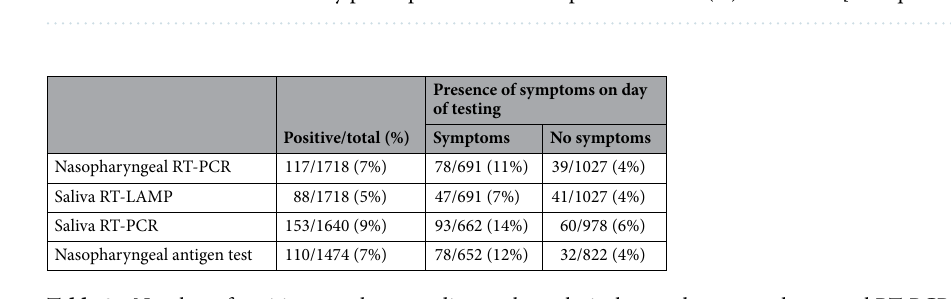
Table 2. Number of positive samples according to the technical procedure: nasopharyngeal RT-PCR, saliva RT-LAMP or RT-PCR and nasopharyngeal antigen test.